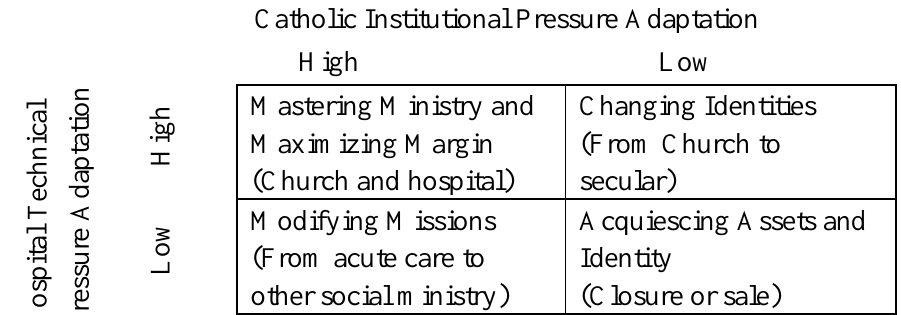
Figure 3. Adaptation of Catholic